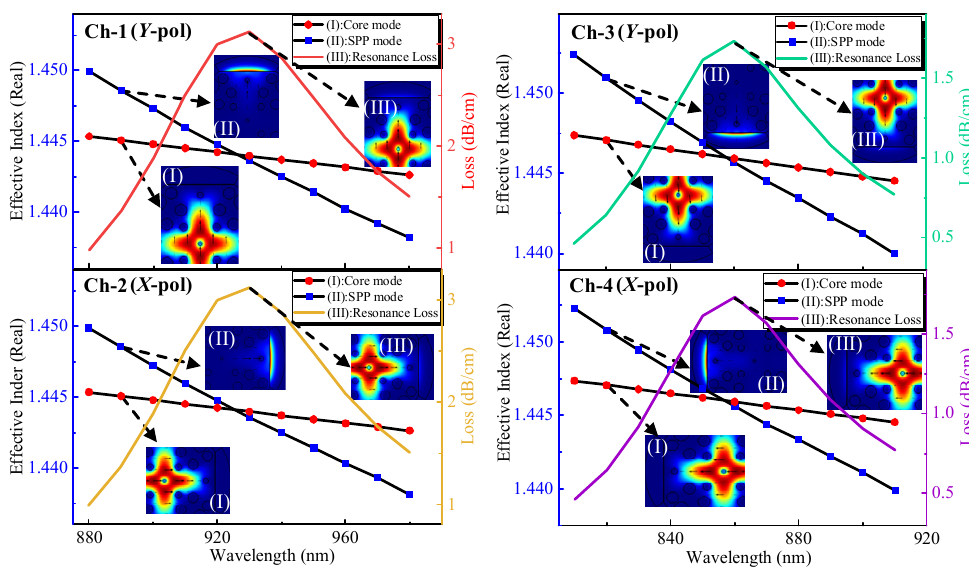
Figure 2. Modes analysis and dispersion relationship of each channel in RI 1.40.